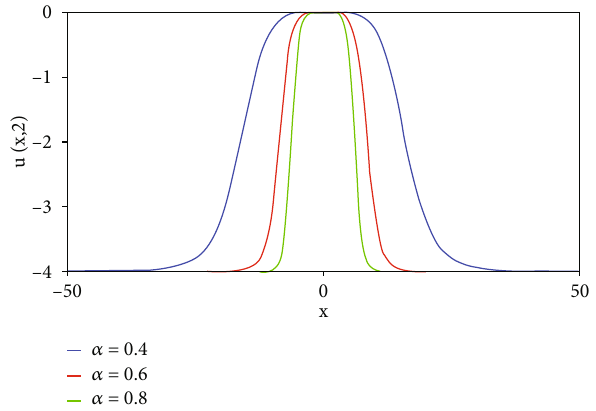
Figure 5: Figure of solution (31) with various fractional orders when v = 2 and t is fi xed at